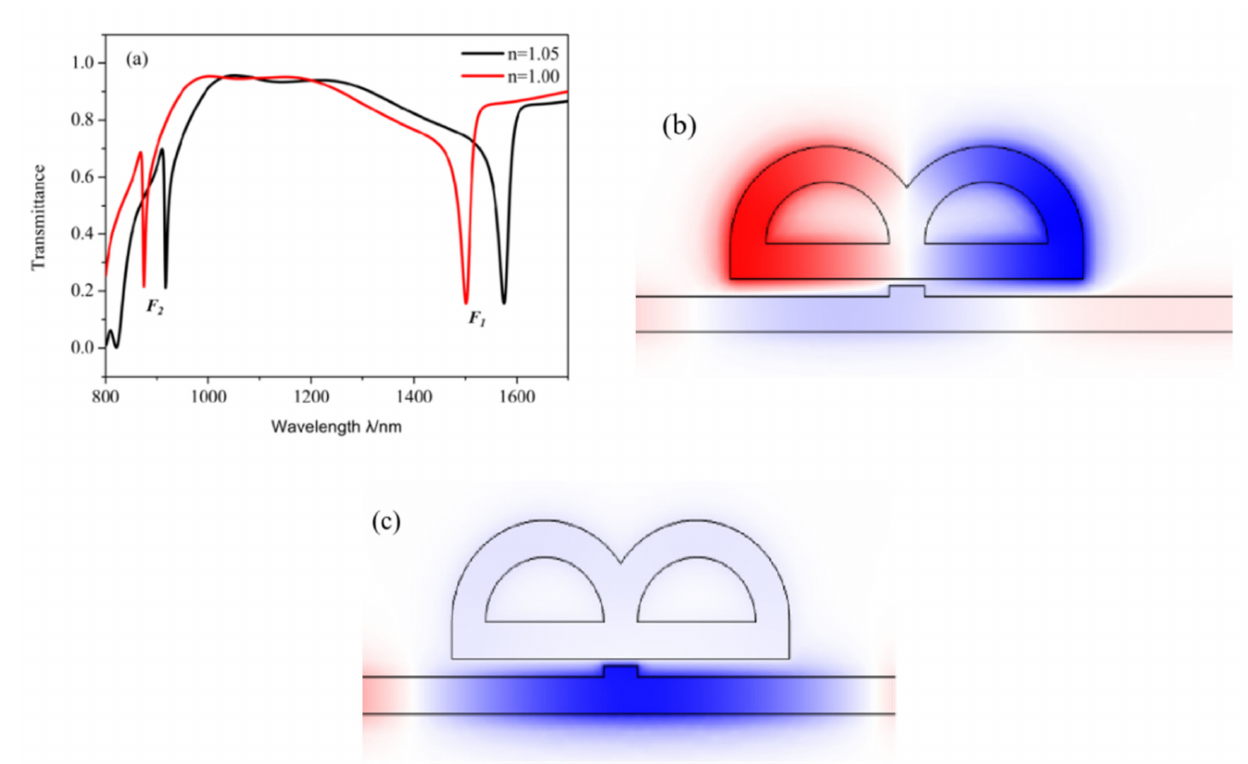
Figure 3. ( a ) Transmission spectrum of the system; ( b , c ) the magnetic field distribution H Z at λ = 1500 and 2000